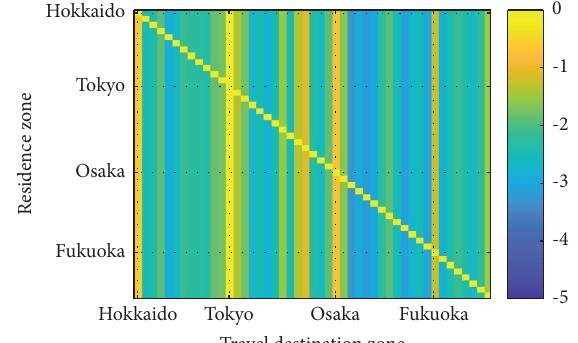
Figure 6: Estimated destination amenity matrix ( A